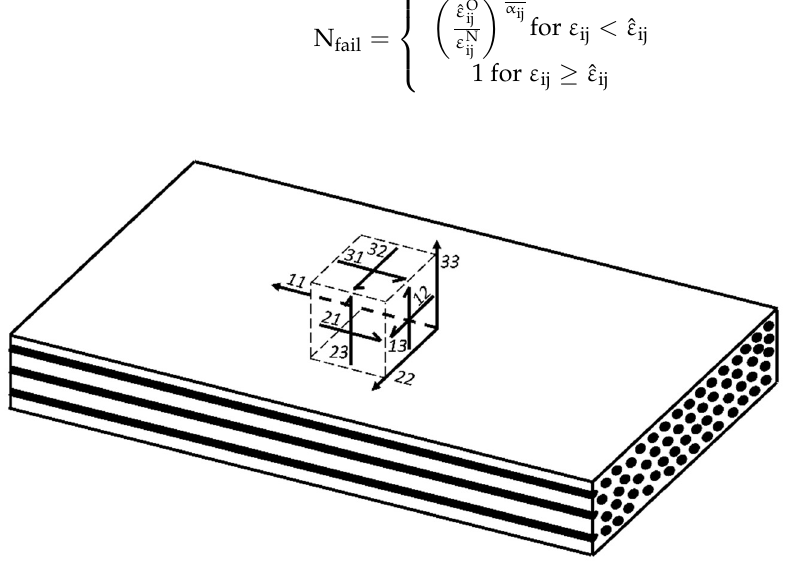
Figure 5. Definition of material directions/components.